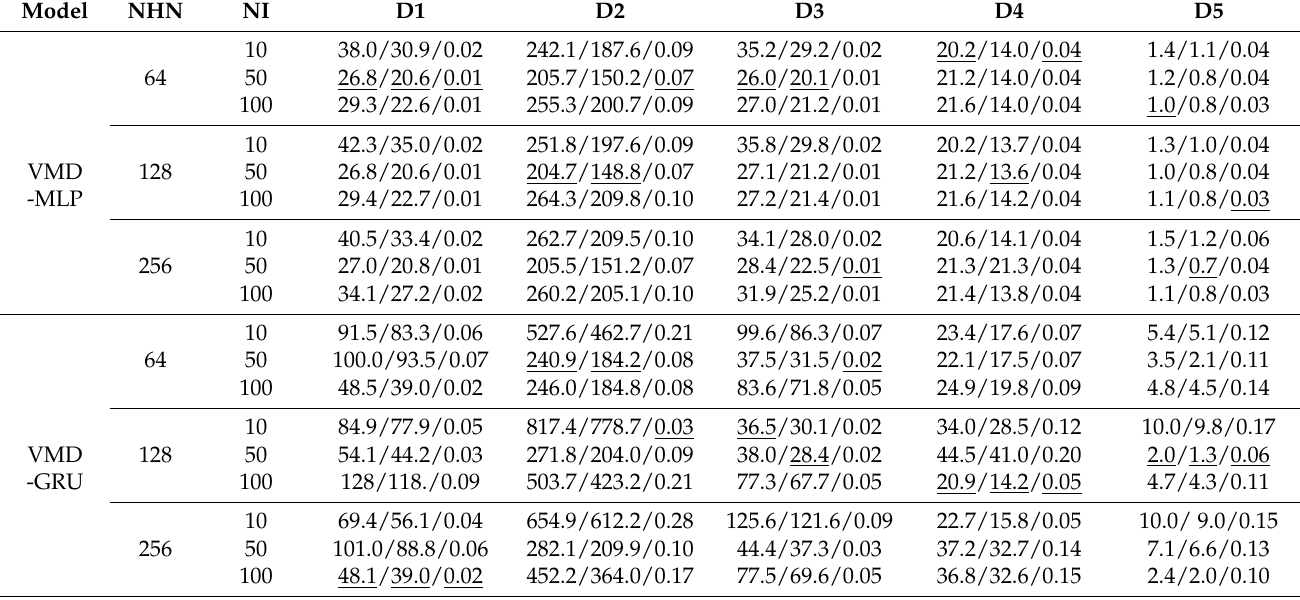
Table 3. Prediction error of 5 h